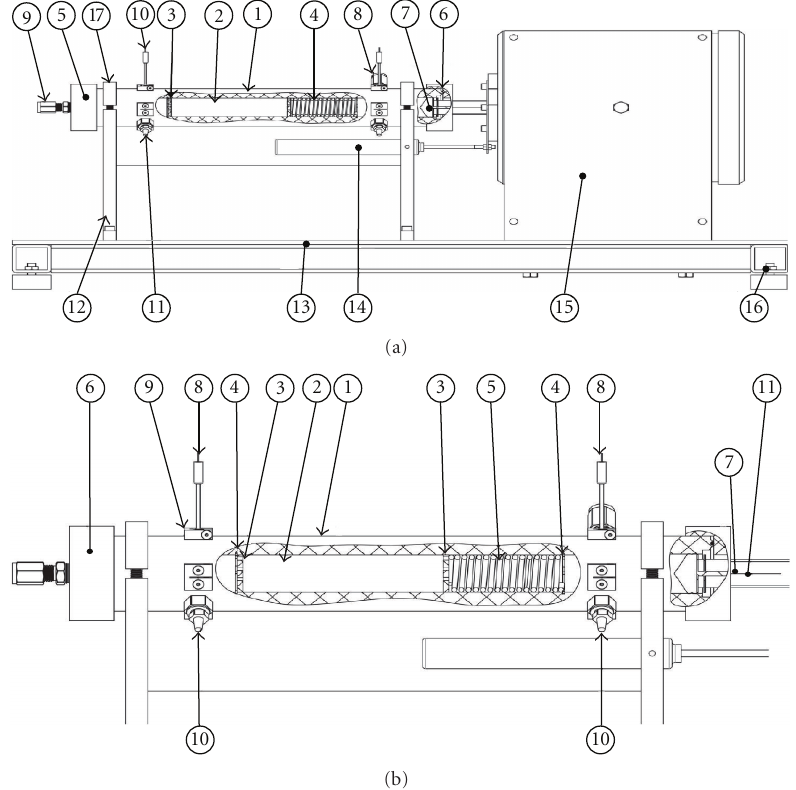
Figure 5: Detailed design of the electromagnetic drive apparatus: (a) complete, (1) perspex tube, (2) sample, (3) drilled polycarbonate disk, (4) spring, (5) screwed output end enclosure, (6) screwed input end enclosure, (7) piston, (8) fluid input check valve (Swagelok), (9) fluid output connector (Swagelok), (10) downstream streaming potential electrode, (11) downstream dynamic pressure transducer, (12) steel frame, (13) steel base, (14) LVDT, (15) EM shaker, (16) adjustable vibration damping feet, and (17) clamp to hold tube. (b) Details of the piston assembly, (1) perspex tube, (2) sample, (3) drilled polycarbonate disk, (4) circlip, (5) spring, (6) screwed output end enclosure, (7) screwed input end enclosure, (8) streaming potential electrodes ( × 2), (9) sealing mechanism for inserting streaming potential electrodes, (10) dynamic pressure transducers ( × 2) downstream, and (11)